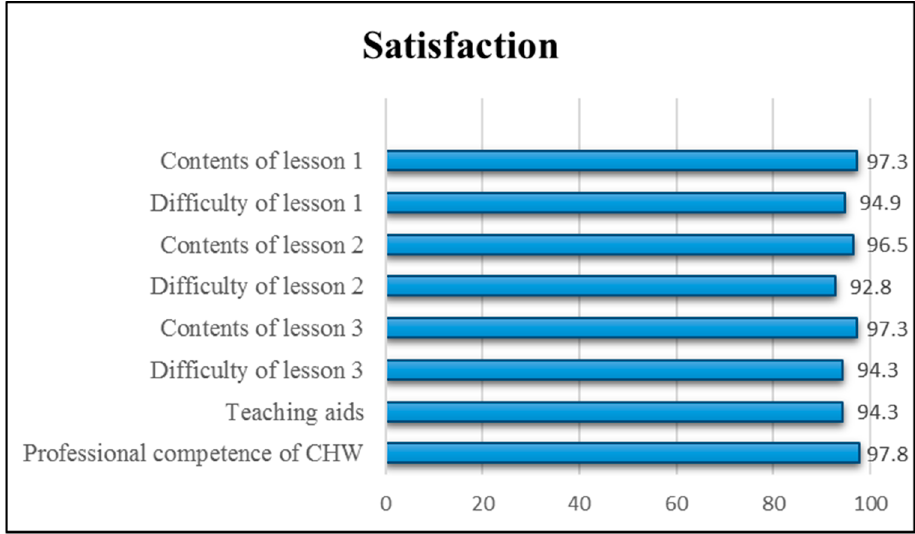
Figure 2. Satisfaction survey results of EG on periodontal care intervention (N = 35).